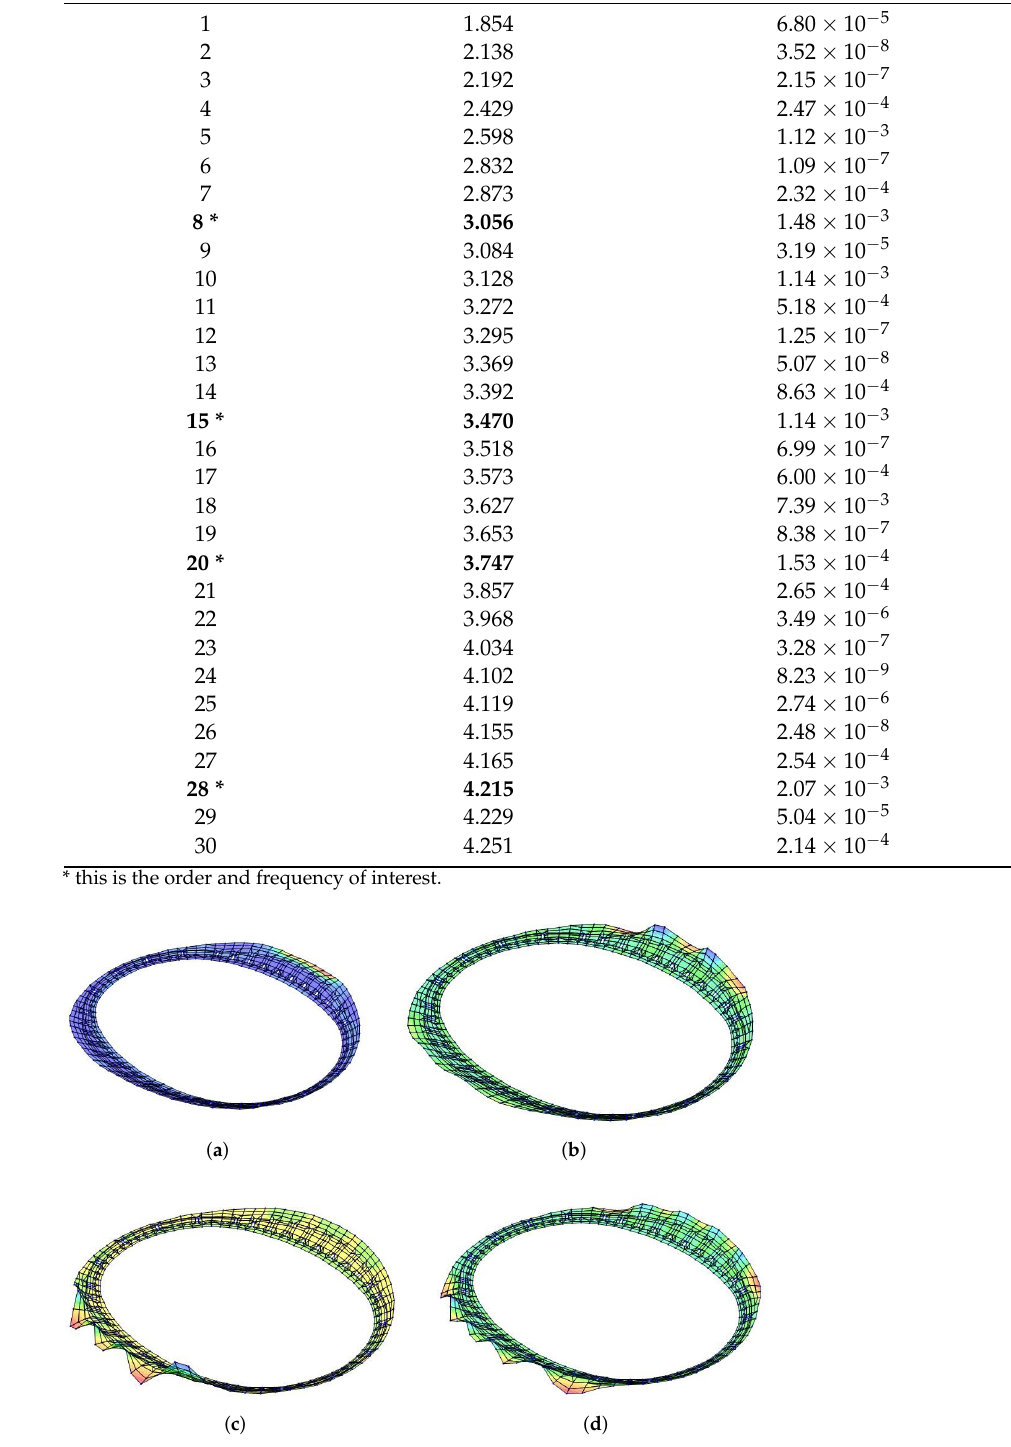
Figure 7. Local vibration diagram of cantilevered part: ( a ) 8th mode is 3.056 Hz; ( b ) 15th mode shape is 3.470 Hz; ( c ) 20th mode is 3.747 Hz; ( d ) 28th mode is 4.215